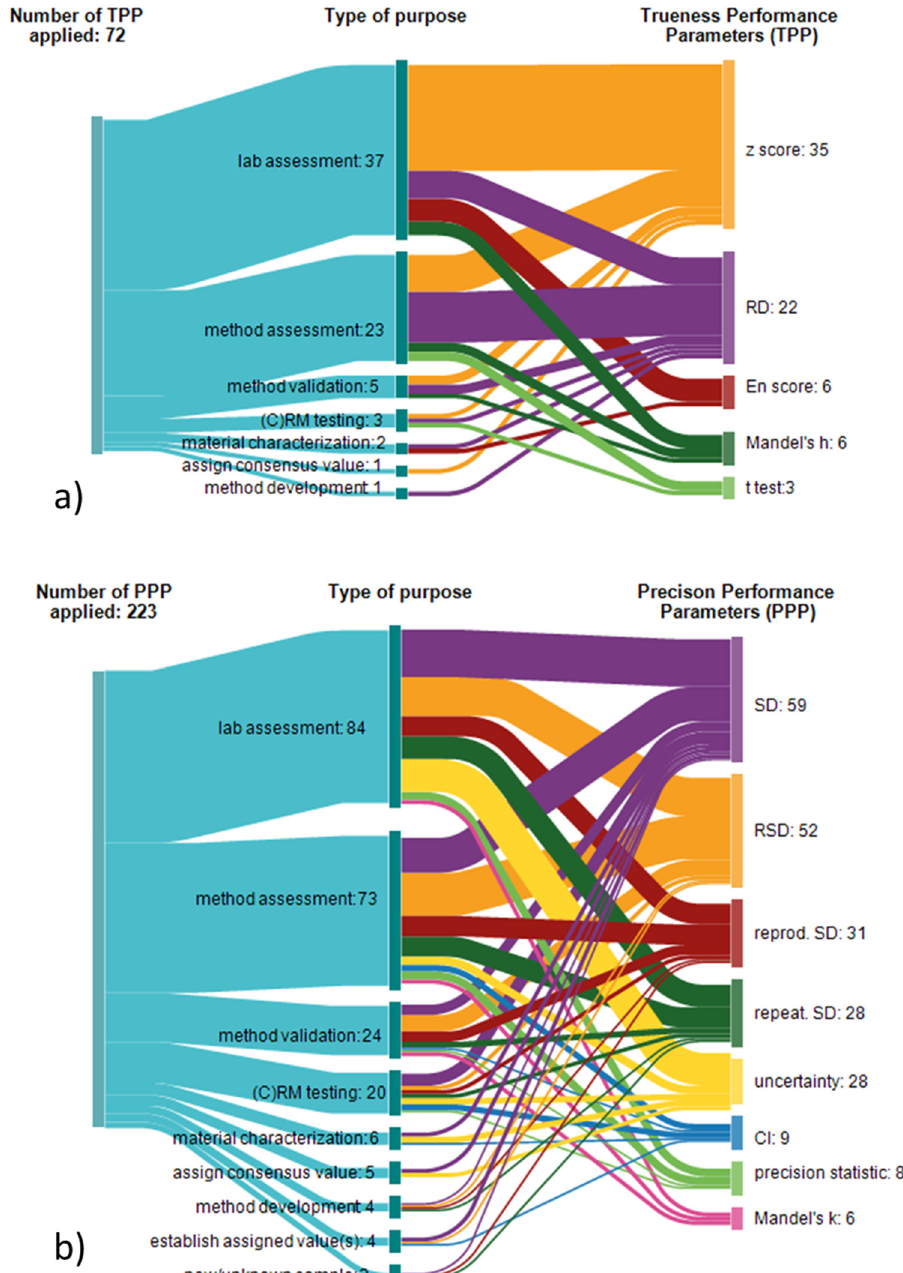
Figure 4: Relationship between ( a ) RRT purpose and TPP and ( b ) RRT purpose and PPP. The data in the fi gures are build on the review of refs [ 13 – 98 ]